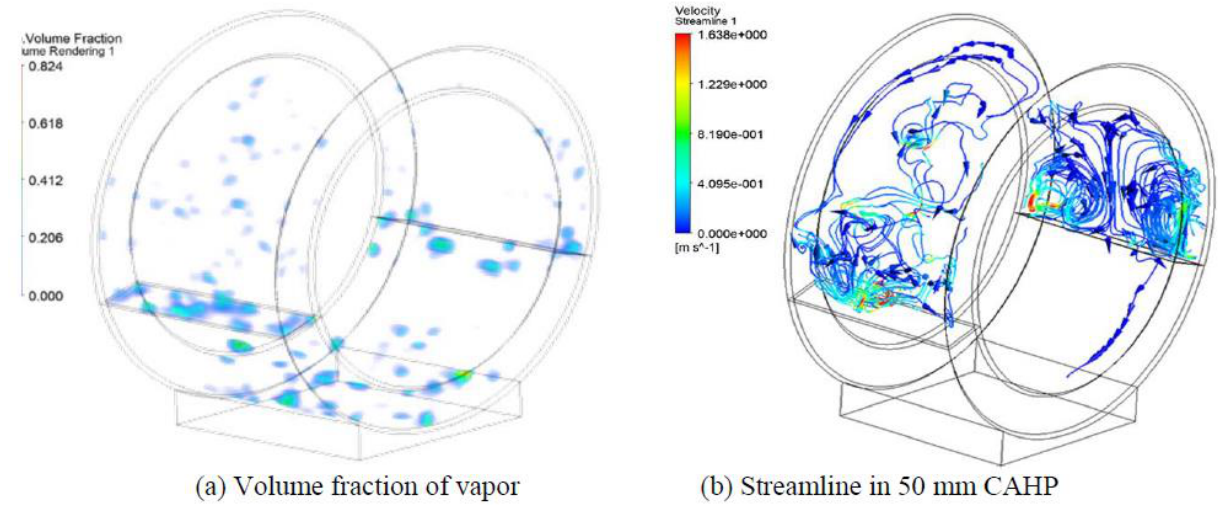
Figure 16. 3-D Simulation, Volume fraction 3-D contour and streamline, D + = 1.3, L = 50 mm, Model ‘A’, CAHP.